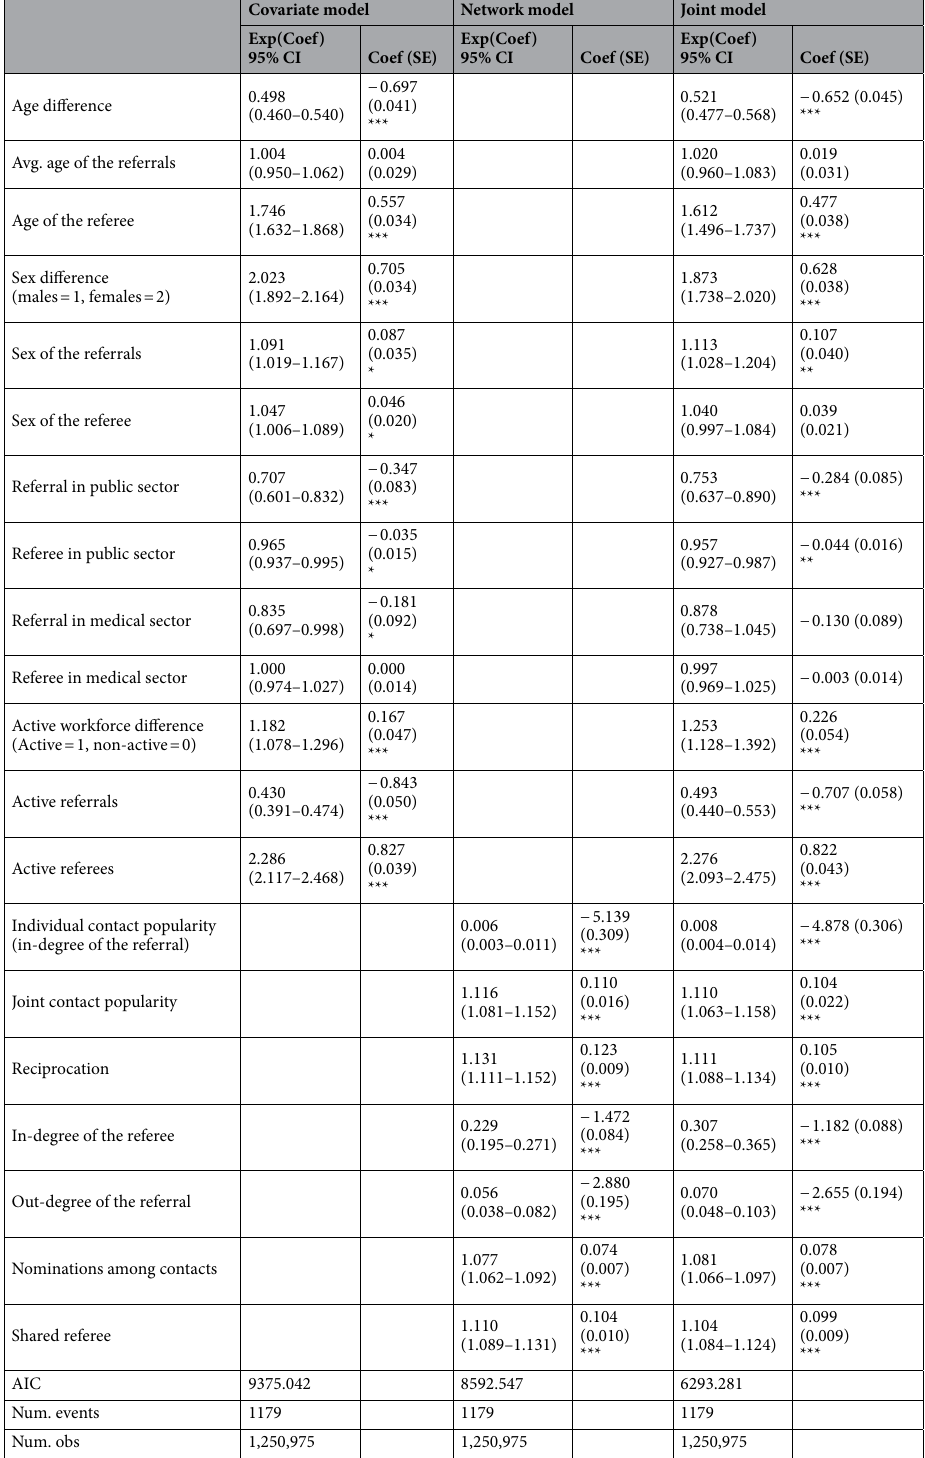
Table 2. Relational hyperevent model assessment: comparing the covariate, the network, and the joint models. *** p < 0.001; ** p < 0.01; * p < 0.05; p < 0.1. The Table provides the hazard ratios (Exp(Coef.)), their 95% confidence intervals, the effects (Coef.) and the p value for each variable included in the